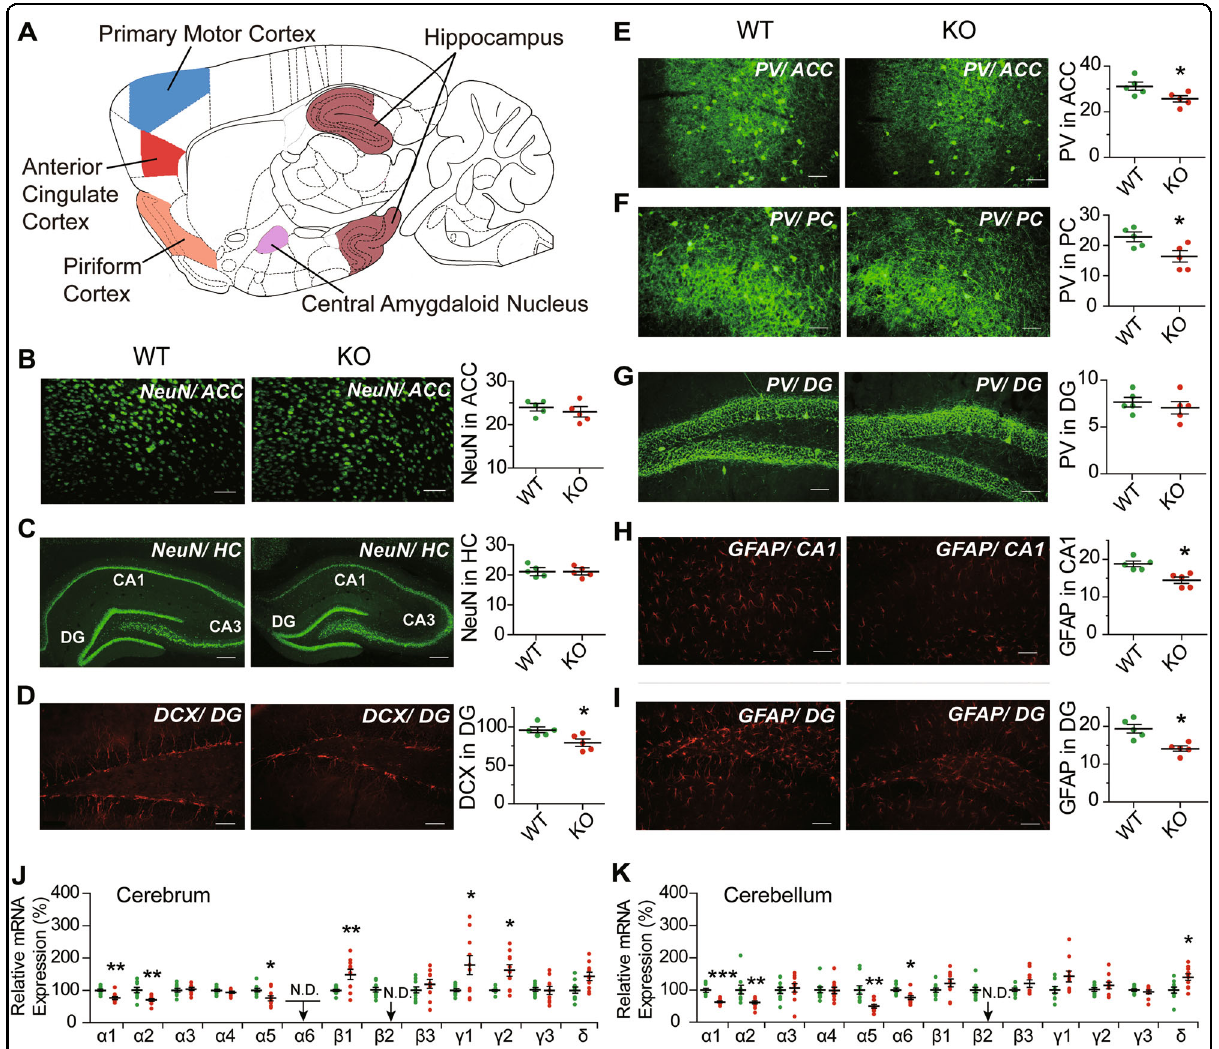
Fig. 4 Neuron and astrocyte immunohistochemical analysis and mRNA expression of GABA A receptor subunits. a Outline of sagittal section of mouse brain, showing the brain regions analyzed using immunohistochemical staining. b – i Coronal sections stained through fl uorescence- labeling of: b NeuN in anterior cingulate cortex (ACC); c NeuN in hippocampus (HC); d DCX in dentate gyrus (DG); e parvalbumin (PV) in ACC; f PV in piriform cortex (PC); g PV in DG; h GFAP in CA1 region; and i GFAP in DG. The DG, CA1, and CA3 regions in hippocampus are indicated in part ( c ). NeuN and PV immuno fl uorescence are displayed in green (scale bar = 300 μ m), and that of DCX and GFAP and DCX displayed in red (scale bar = 120 μ m). The plots show immuno fl uorescence densities for WT (green dots) and KO (red dots) estimated in terms of average area optical density (in parts b , c , e , h , and i ), or in terms of the number of immunoreactive cells (in parts d , f , g ); in each instance, fi ve randomly selected images from each of fi ve WT or KO male mice were examined. The levels of mRNA expression for 13 different GABA A receptor subunits in WT and KO mouse cerebrum ( j ) and cerebellum ( k ) were measured using quantitative RT-PCR, and the mRNA levels in KO mice were normalized to the average expression level in WT ( n = 10 in each group). The measured expression levels in WT, KO as well as HT brains are given in Supplementary Table S4. Statistical analysis was performed using unpaired t -test for immunohistochemical staining and one-way ANOVA with Newman – Keuls post-hoc test for mRNA quantitation. Average y values± SEM in the different plots are represented by horizontal bars; WT is represented by green dots and KO by red dots. N.D. represents non-detectable; * p < 0.05, ** p < 0.01, *** p <